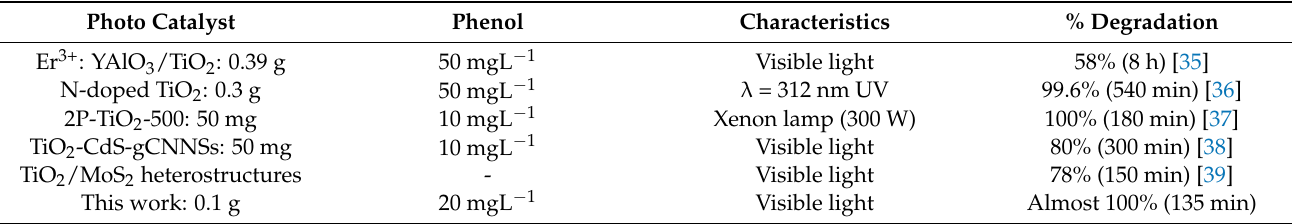
Table 1. Comparison of catalyst